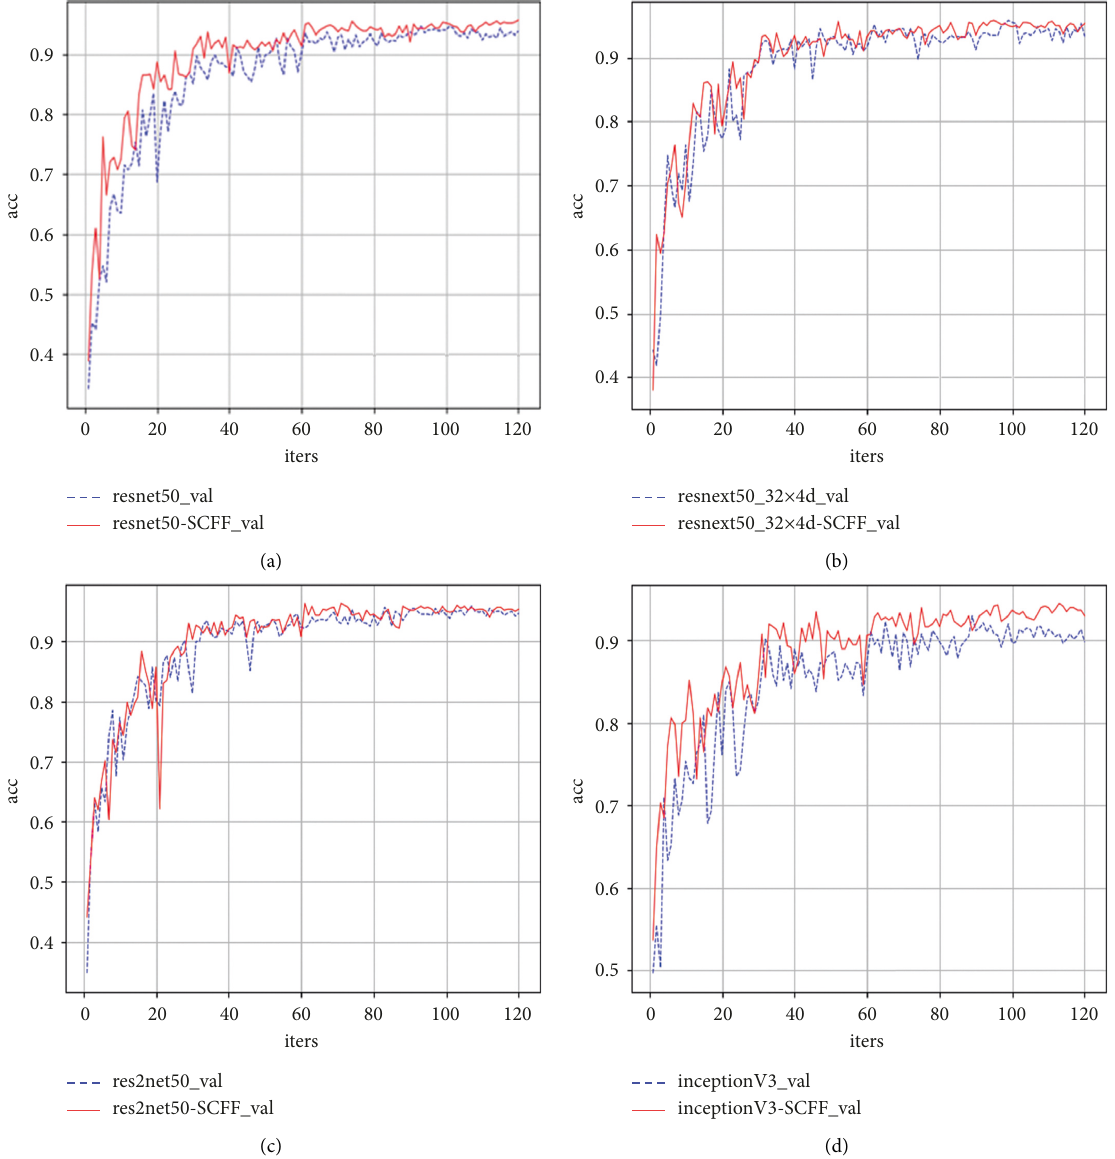
Figure 8: Comparison of the network accuracy curve before and after the introduction of SCFF model. (a) ResNet50 Model. (b) ResNext50 Model. (c) Res2Net Model. (d) InceptionV3